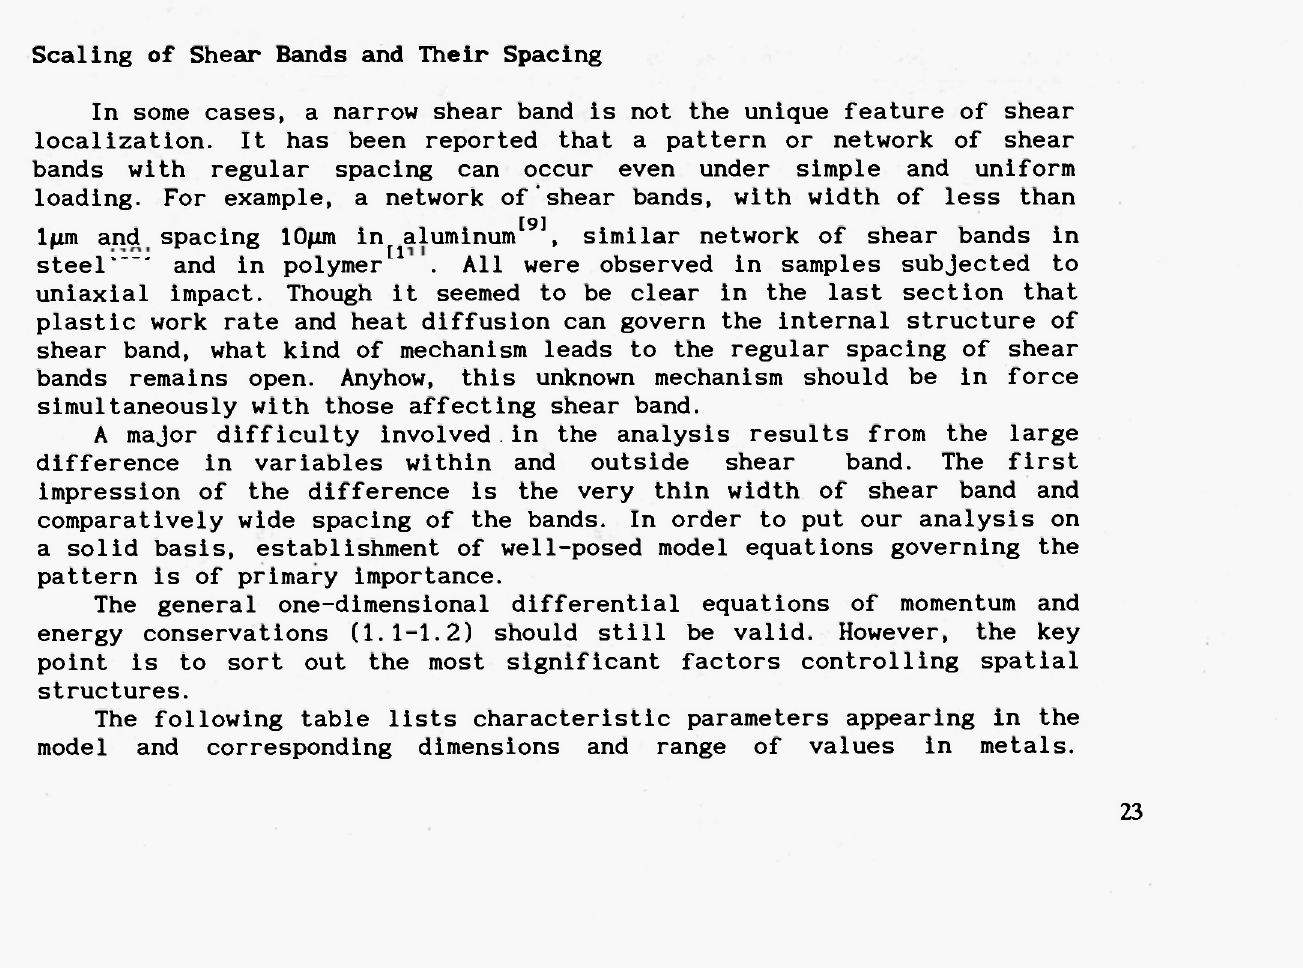
Fig. 1 Scheme of shear band